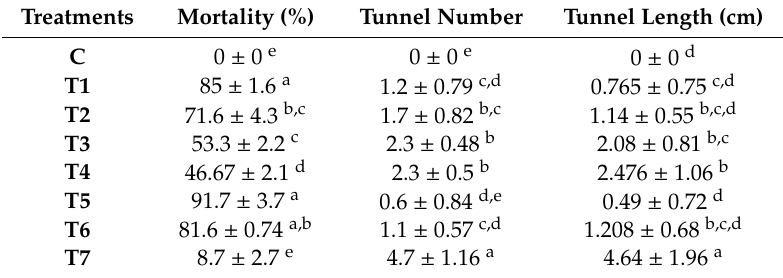
Table 2. Effect of fungal inoculation on mortality (%) of O. furnacalis, number and length of tunnels in maize plants. Each value is the mean of three different replicates ± standard deviation. Treatment details: uninoculated and uninfested control (C) ; seed coating with B. bassiana OFDH1-5 (T1) ; soil drenching with B. bassiana OFDH1-5 (T2) ; seed coating with T. asperellum GDFS1009 (T3) ; soil drenching with T. asperellum GDFS1009 (T4) ; seed treatment with binary combination of B. bassiana OFDH1-5 + T. asperellum GDFS1009 (T5) ; soil drenching with binary combination of B. bassiana OFDH1-5 + T. asperellum GDFS1009 (T6) ; infested control (insect control) (T7) .